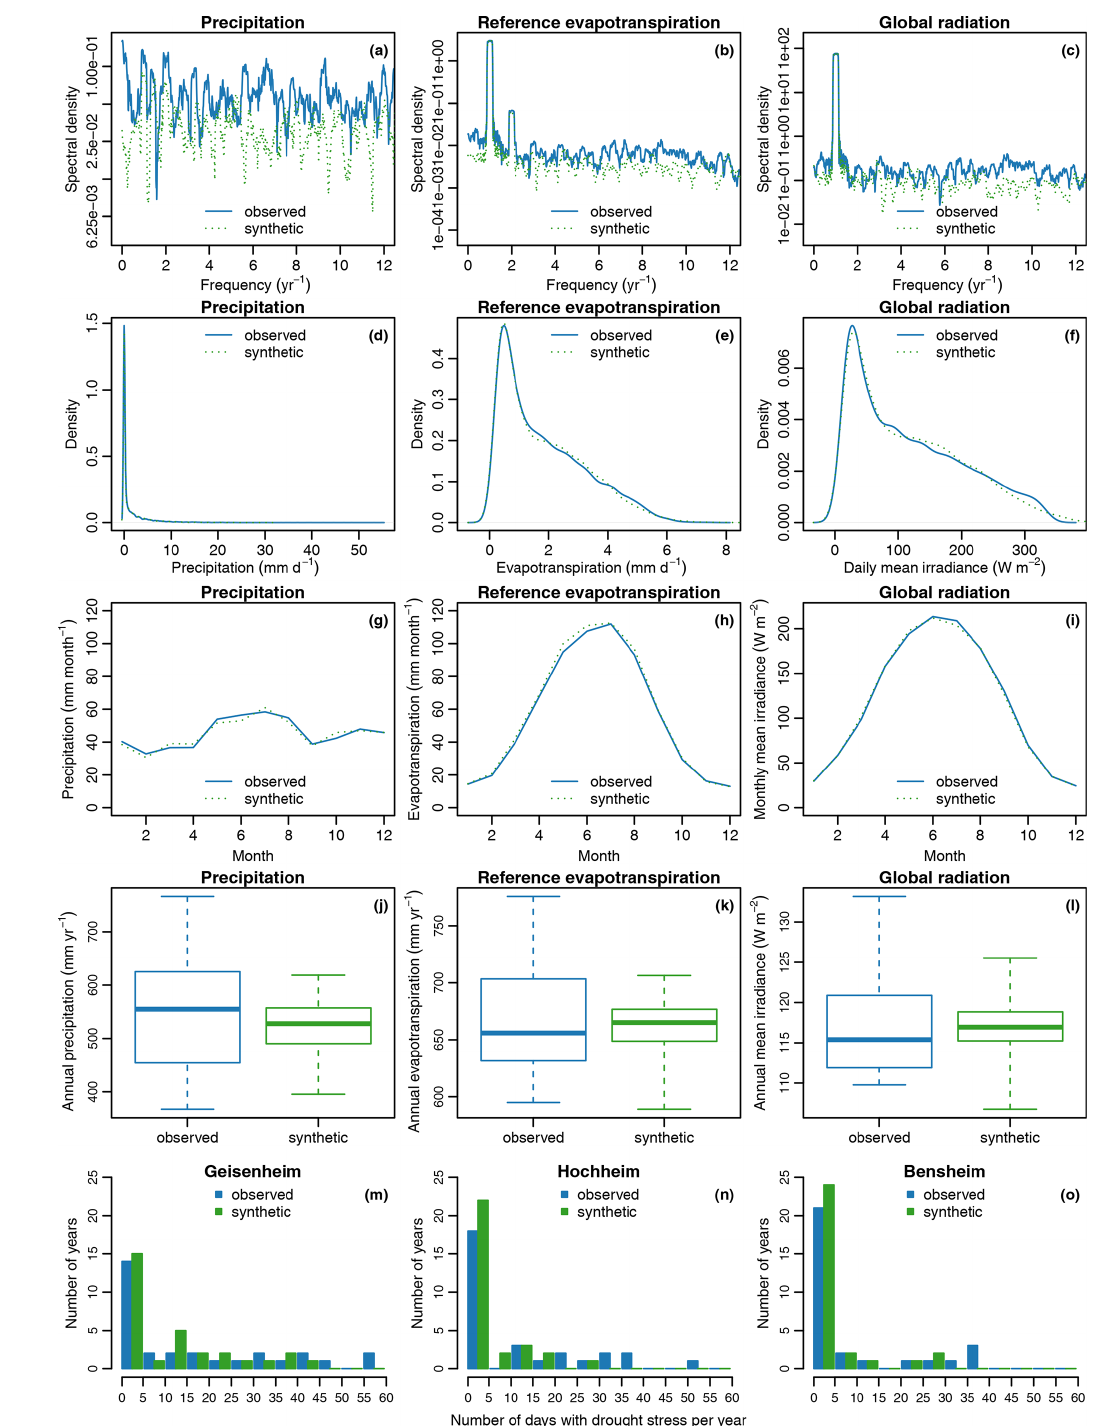
Figure 2. Comparison of 30 years of observational weather data (1959–1988, station Geisenheim, Rheingau, Germany) and 30 years of synthetic weather data produced by the weather generator calibrated with the observational weather data. (a–c) Power spectra of daily data of precipitation, reference evapotranspiration, and global radiation. (d–f) Probability density functions of daily data computed with kernel density estimates. (g–i) Monthly means. (j–l) Box-and-whisker plots of annual values. The central box shows the interquartile range, the bold line the median; the whiskers extend to the extremes. (m–o) Histograms of the number of drought stress days per year ( n = 30 years) calculated with a water balance model for a vineyard with low available water capacity (100mm) based on the data of Geisenheim (m) and two other weather stations of Hochheim (n) and Bensheim (o) for the same time period.